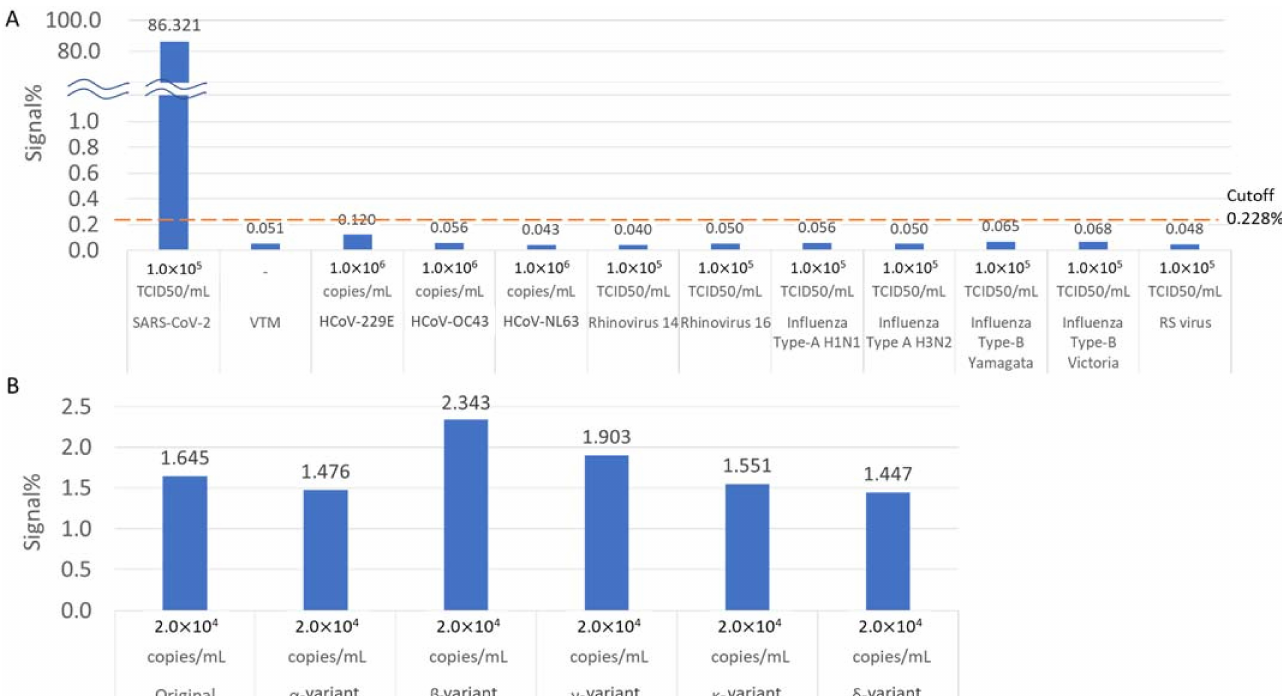
Figure 6. Cross-reactivity and variant detection. ( A ) Results of 1.0 × 10 5 TCID50/mlL SARS-CoV-2, 1.0 × 10 6 copies/mL HCoV-229E, 1 × 10 6 copies/mL HCoV-OC43, 1.0 × 10 6 copies/mL HCoV-NL63, 1.0 × 10 5 TCID50/mL Rhinovirus 14, 1.0 × 10 5 TCID50/mL Rhinovirus 16, 1.0 × 10 5 TCID50/mL 1.0 × 10 5 TCID50/mL Influenza Type B Yamagata, 1.0 × 10 5 TCID50/mL Influenza Type B